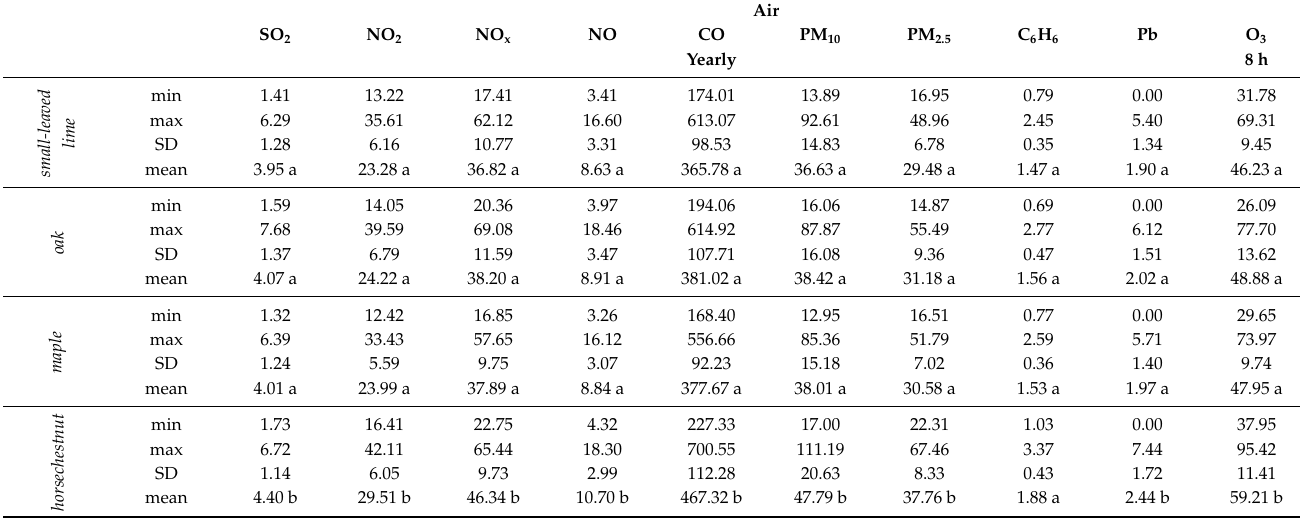
Table 6. Minimum, maximum, average values and standard deviations for the air pollution ( µ g m − 3 ) [45].